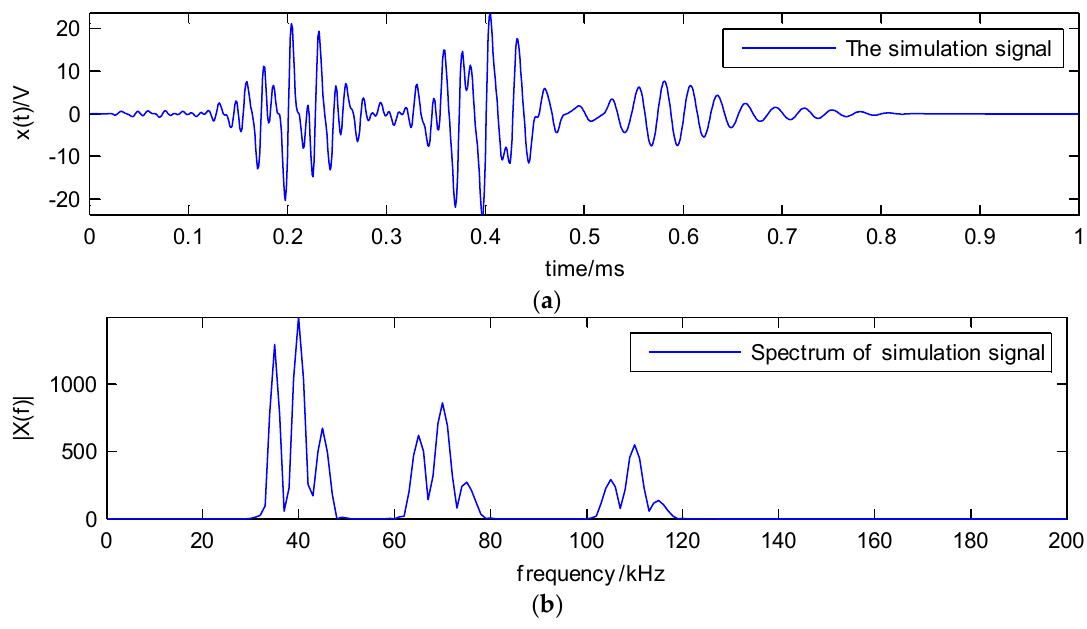
Figure 6. The ( a ) waveform and ( b ) spectrum of simulation signal which is generated by adding 9 different modulated sine burst signals together (the simulation parameters are in Equation (14) and the expression of each signal is in Equation (12)). Based on the local maxima, segmentation boundaries are obtained which are the red dashed lines in Figure 7b, and three spectrum segmentations are shown, denoted by the gray, cyan and green colors. This indicates that the proposed LWM algorithm performs well in searching for the local maxima and segmenting the spectrum.